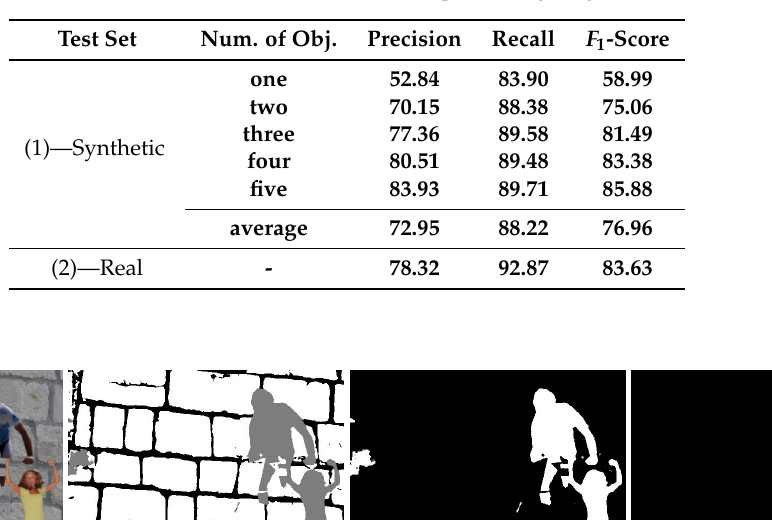
Table 1. Evaluation of occlusion mask extraction in the Pre-processing Stage for Test Set (1) and (2).